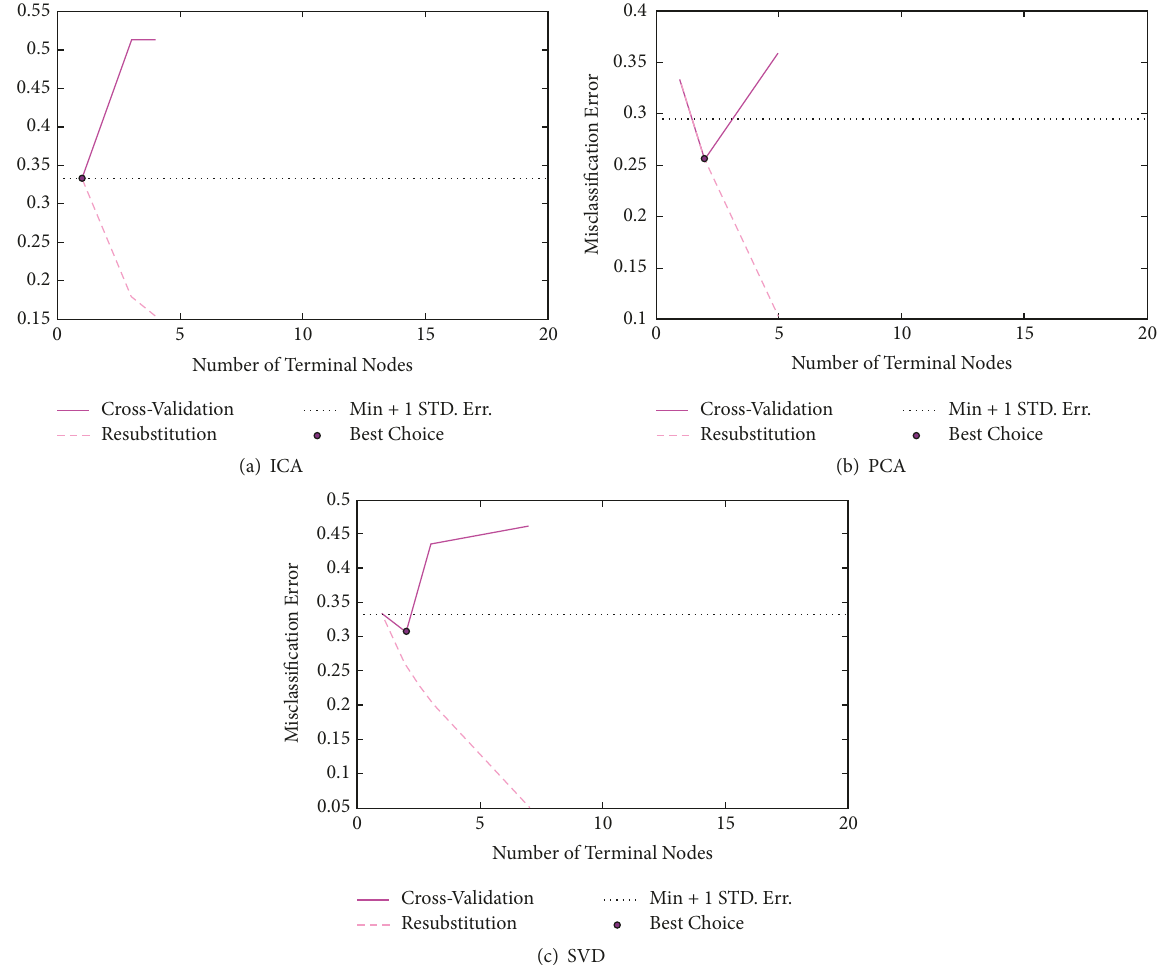
Figure 13: Misclassification error for the CART for different numbers of terminal nodes with ICA, PCA, and SVD data reduction